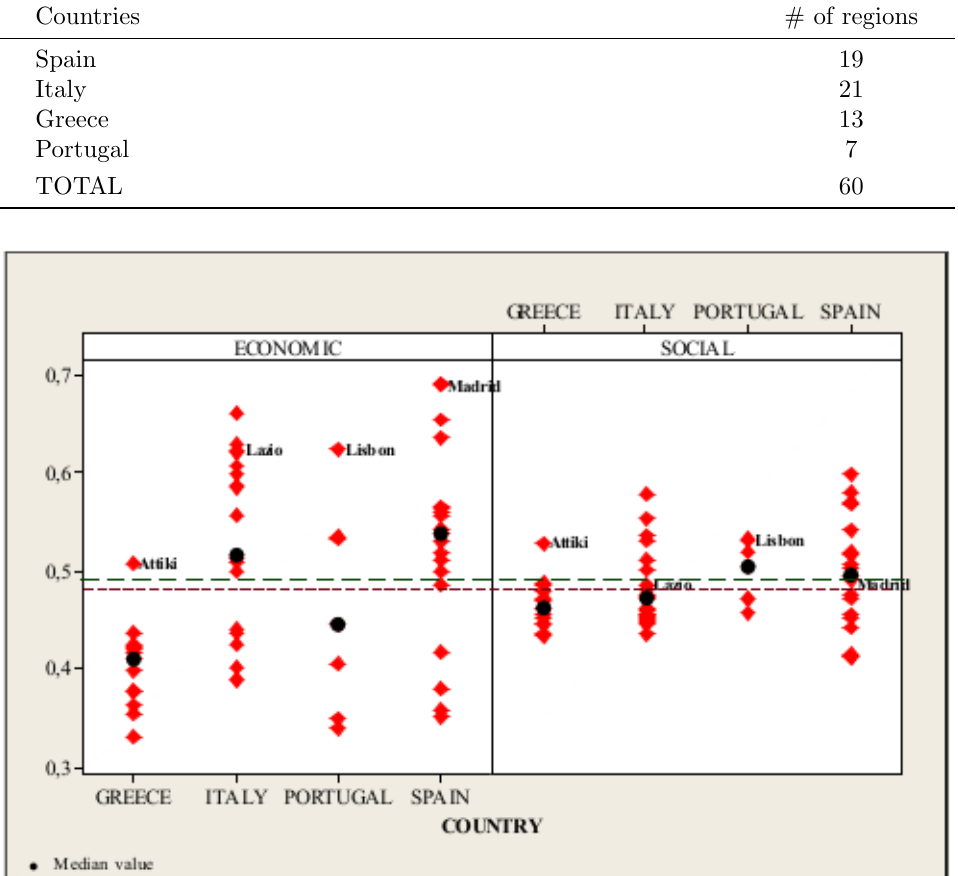
Figure 1: The Economic and Social Indicators of the 60 south European